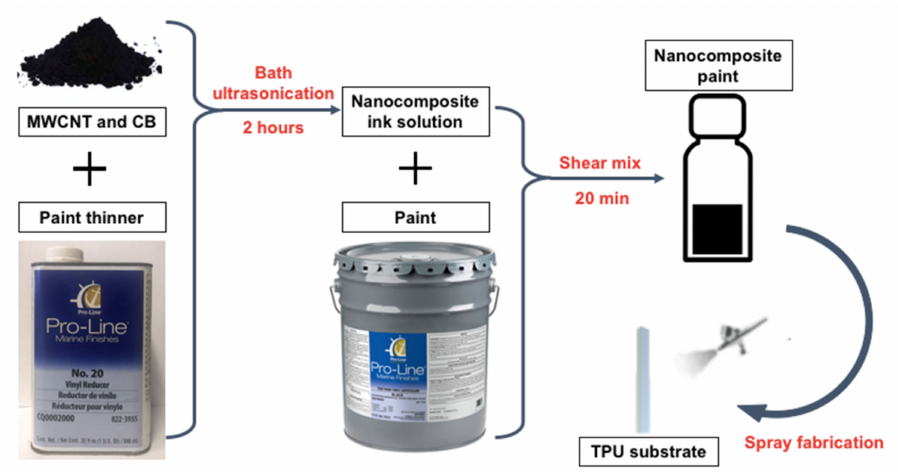
Figure 1. The CNT-CB nanocomposite paint preparation and thin film spray-coating process are